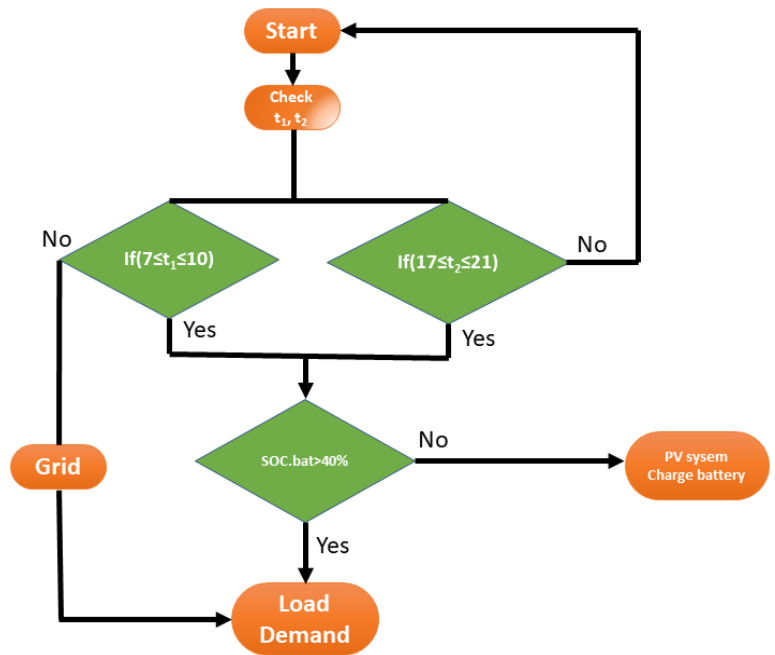
Figure 5. Proposed algorithm for a PV system and battery storage with a controlling device.